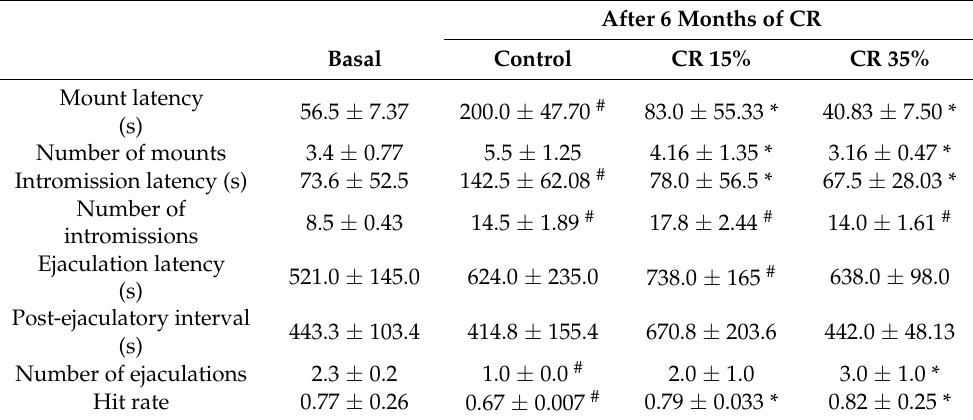
Table 2. Effect of CR on MSB in aged male Wistar rats. After 6 Months of CR Basal Control